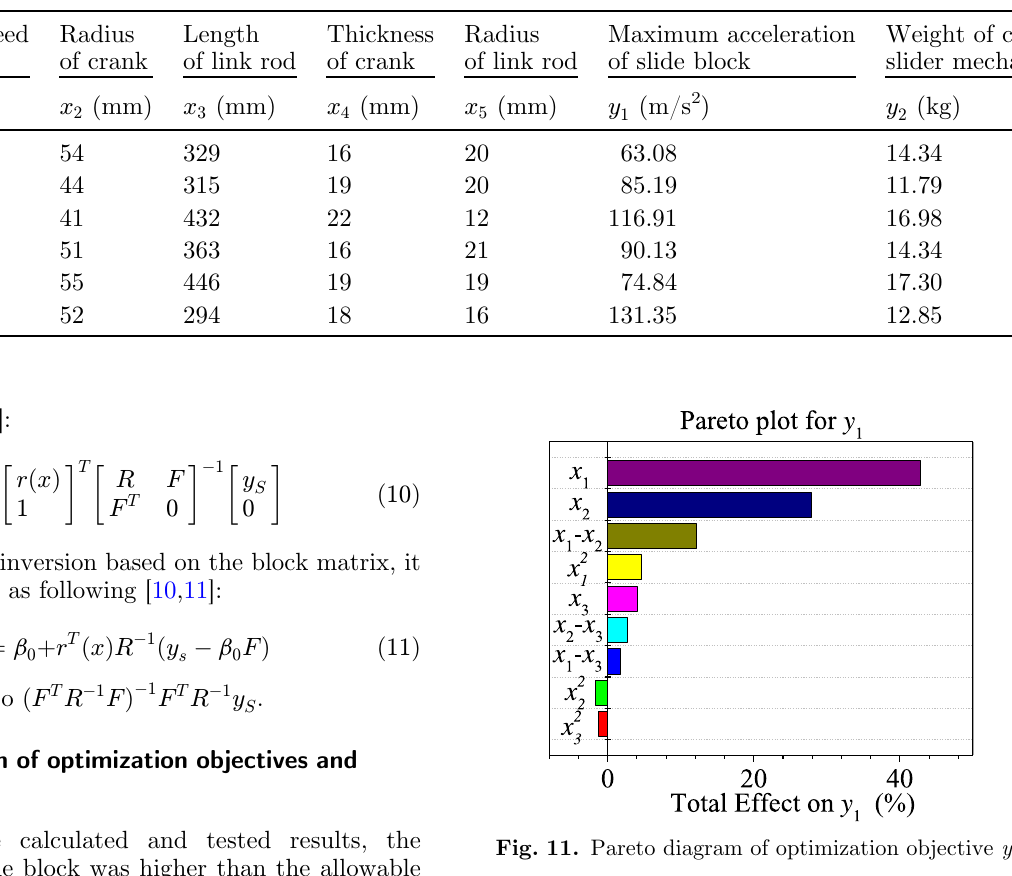
Table 2. Sample data of design variables and corresponding response valued.